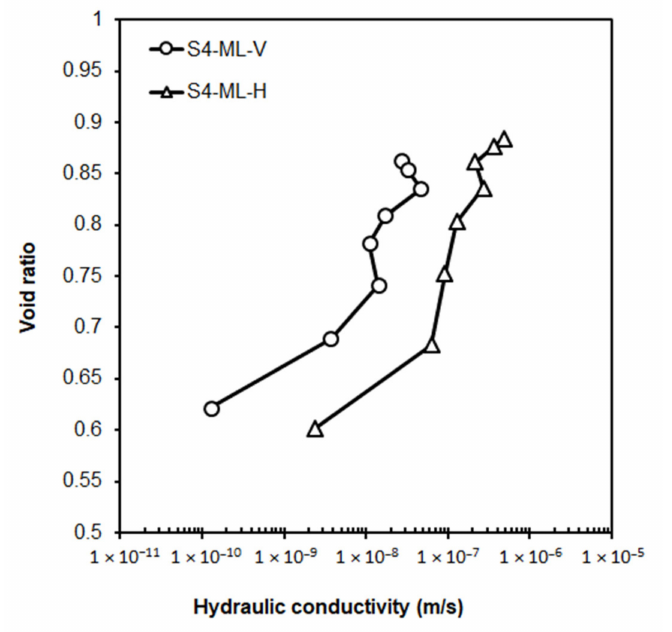
Figure 10. Influence of anisotropy and sampling method (V = vertical permeability and H = horizontal